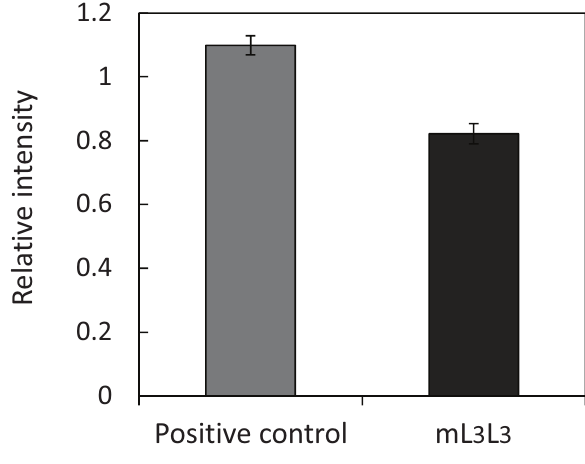
Figure 4. Immunofluorescence intensities of control and mL 3 L 3 yeast strains. The fluorescence intensities of the cells after immunofluorescent labeling were measured. Data represent the means ± S.E.M. of three independent